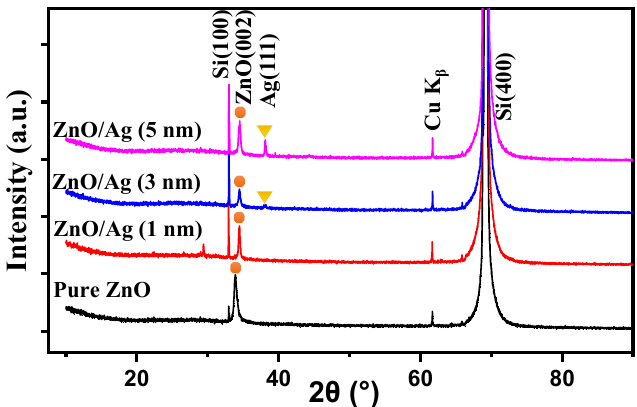
Figure 4. The XRD patterns of annealed ZnO films with different thicknesses of Ag layer.